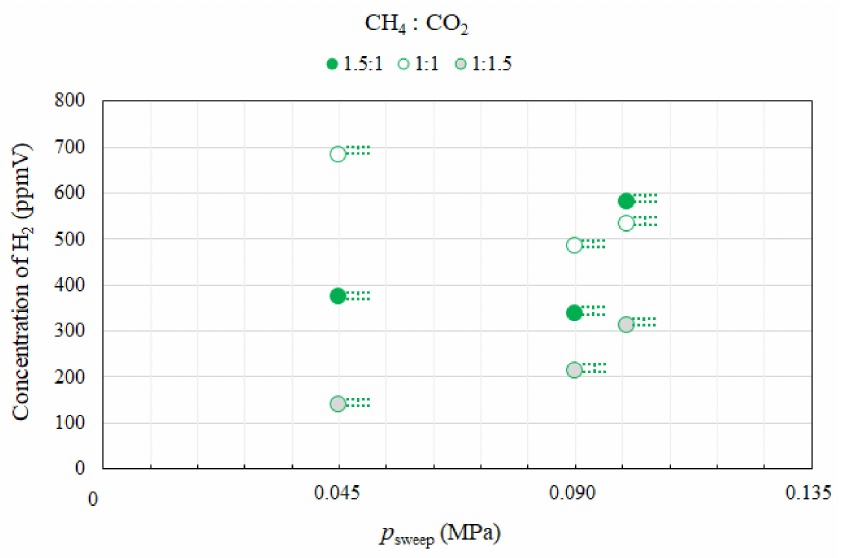
Figure 7. Impact of concentration of H 2 at the outlet of reaction chamber and p sweep with changing molar ratios of CH 4 :CO 2